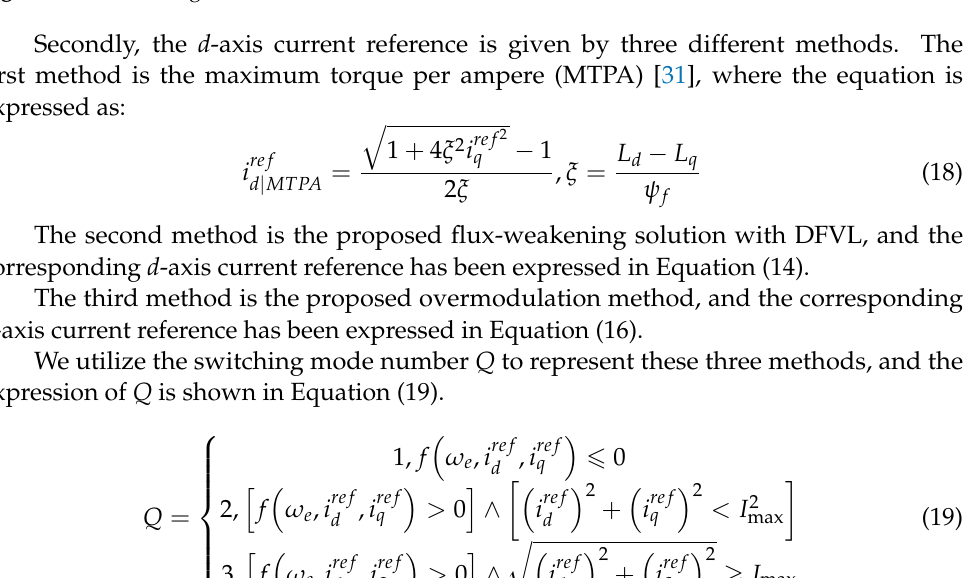
Figure 8. Control diagram of FW-DFVL.